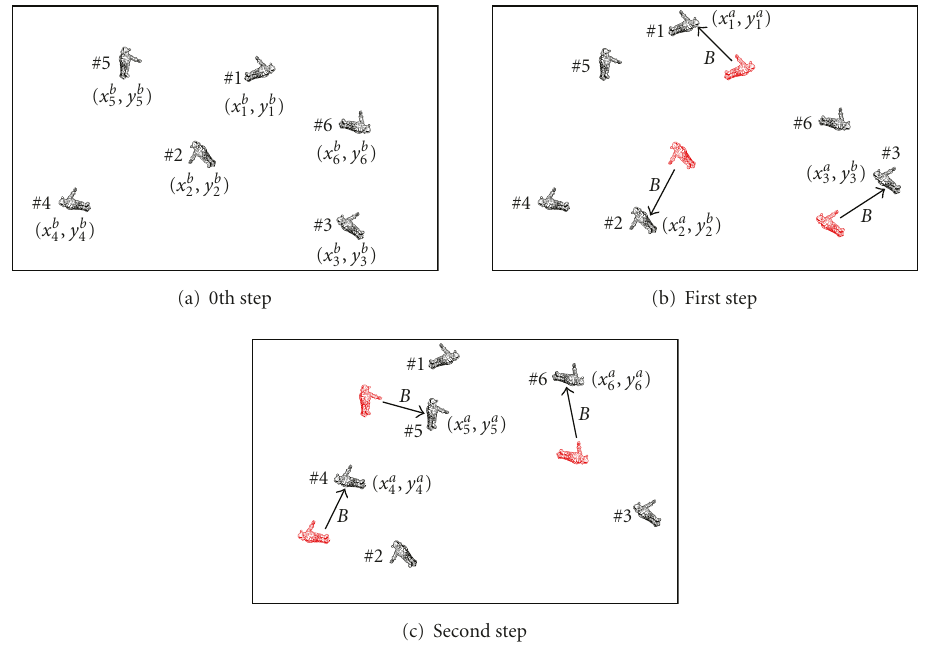
Figure 4: Heading direction estimation with M = 6 and U = 2.